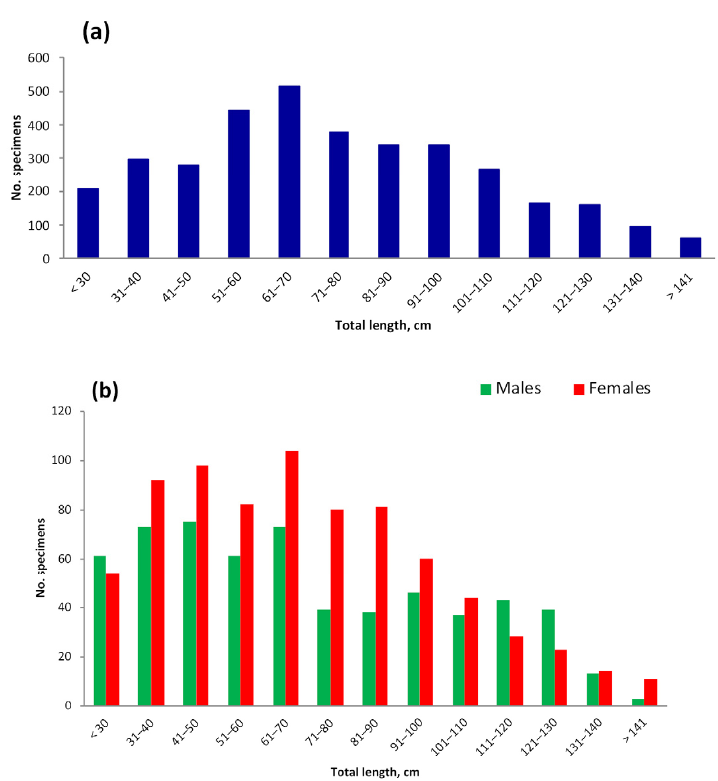
Figure 10. Total length of the Aleutian skate Bathyraja aleutica in catches in the North Pacific Ocean: ( a ) both sexes (M = 66.52 cm, 906 ind.), ( b ) males (, M = 67.94 cm, 364 ind.) and females (, M = 63.69 cm, 341 ind.).